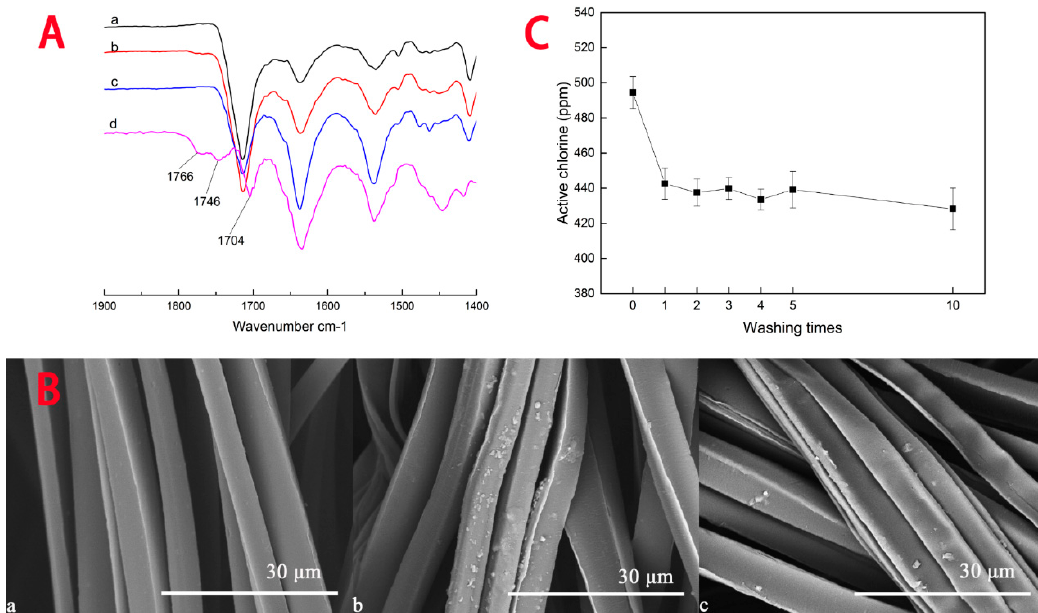
Figure 4. Stability analysis: ( A ) FTIR-ATR spectra of ( a ) pristine fabric, ( b ) grafted fabric, ( c ) ten times washed grafted fabric, and ( d ) difference spectrum, subtracting (a) from (c); ( B ) Scanning electron microscope (SEM) micrographs of ( a ) pristine fabric, ( b ) grafted fabric, ( c ) ten times washed grafted fabric; ( C ) Washing stability of grafted fabrics. Symbol: Mean ± SD.